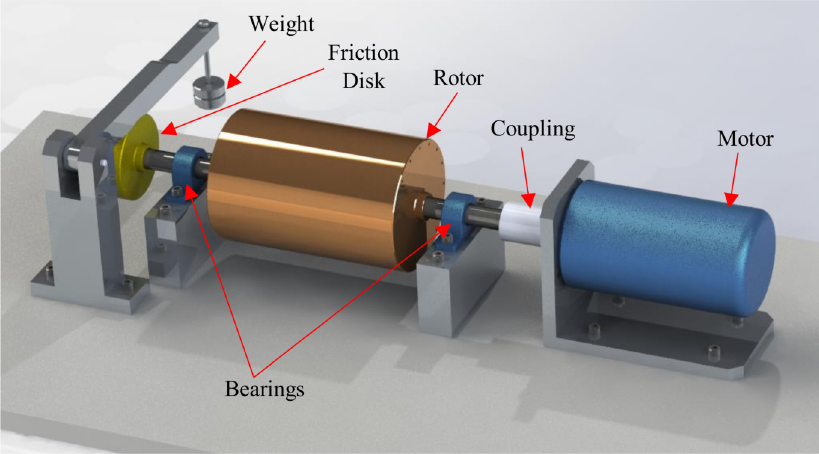
Figure 3. Photo of one application of the proposed